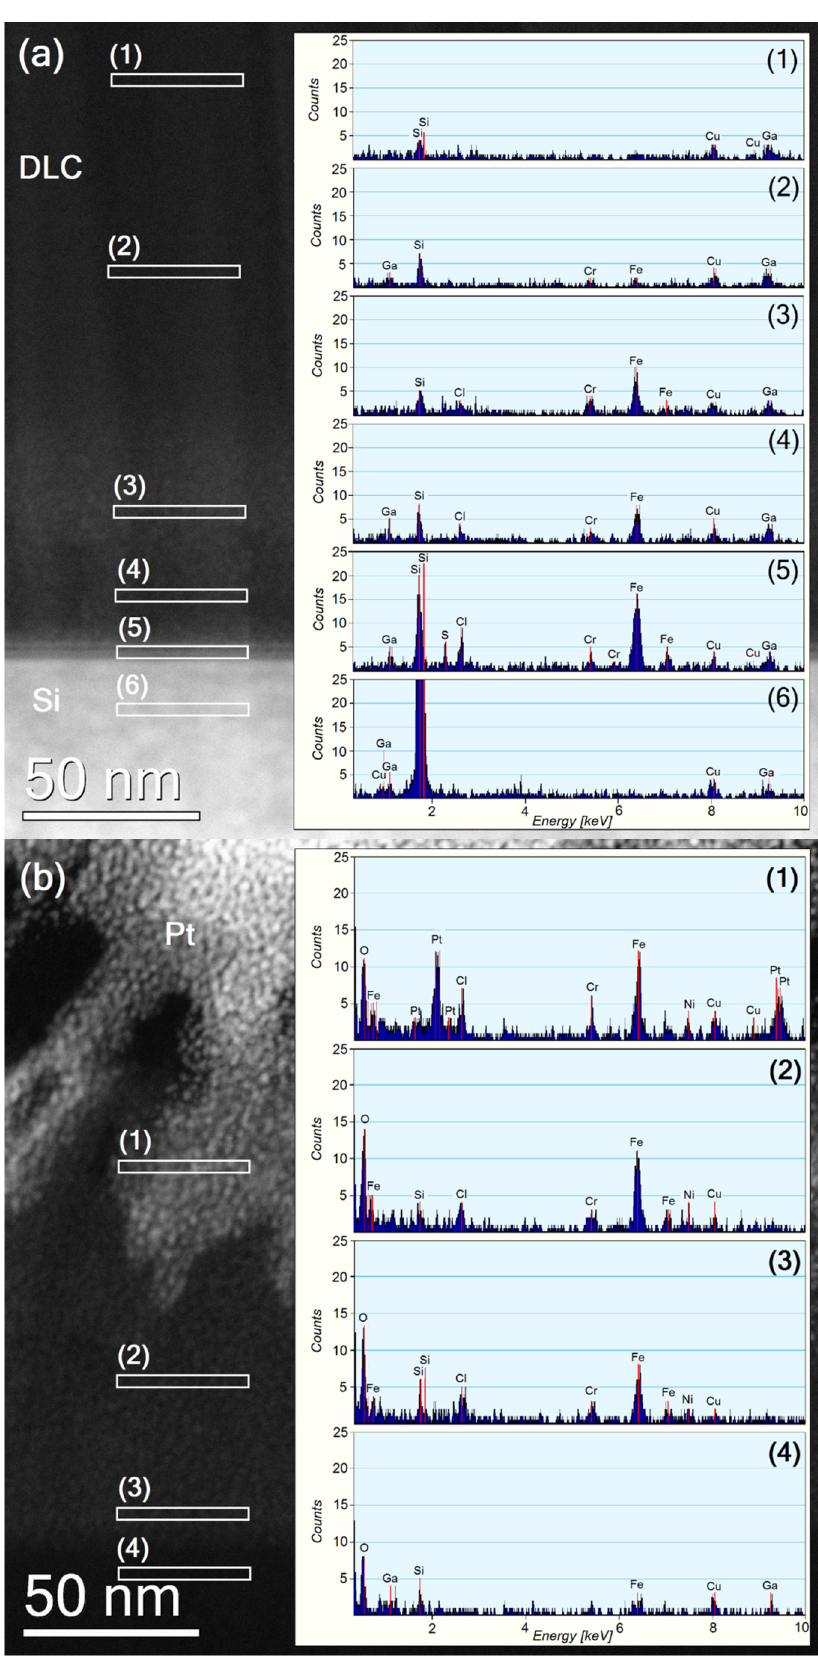
Figure 6. Energy dispersive X-ray spectra of a DLC coating prepared with 8 kV in the interface regions at the substrate ( a ) and the surface ( b